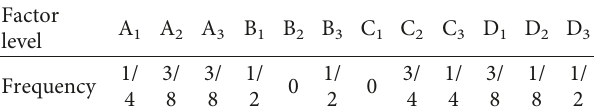
Figure 5: Relationship between factor lever and four evaluation indexes. (a) Head. (b) Shaft power. (c) Efficiency. (d) Pressure pulsation coefficient. Table 8: Comprehensive frequency analysis of three levels cor- responding to four